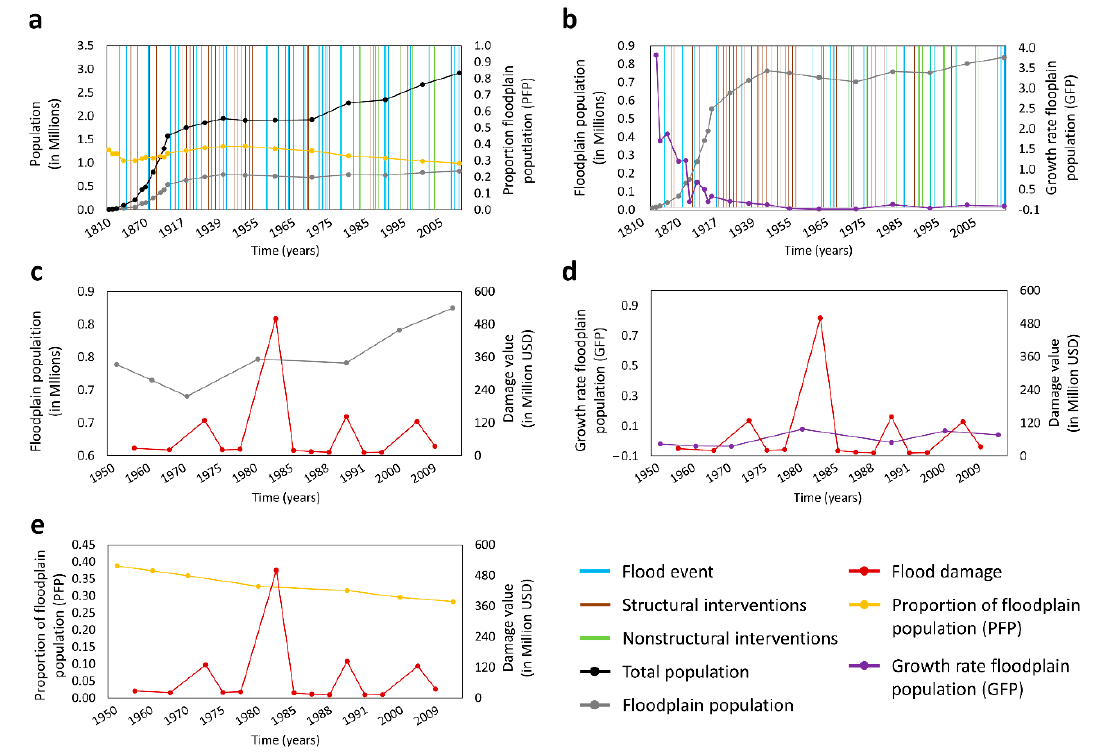
Figure 6. Time-series of floodplain population dynamics, flood events, and related adaptation measures in the state of Arkansans. ( a ) Total state population, floodplain population, proportion of floodplain population, occurrence of flood events, and structural and nonstructural interventions; ( b ) floodplain population, floodplain population growth rate, occurrence of flood events, and structural and nonstructural interventions; ( c – e ) flood damages (in thousand USD), floodplain population, floodplain population growth rate, and proportion of floodplain population.